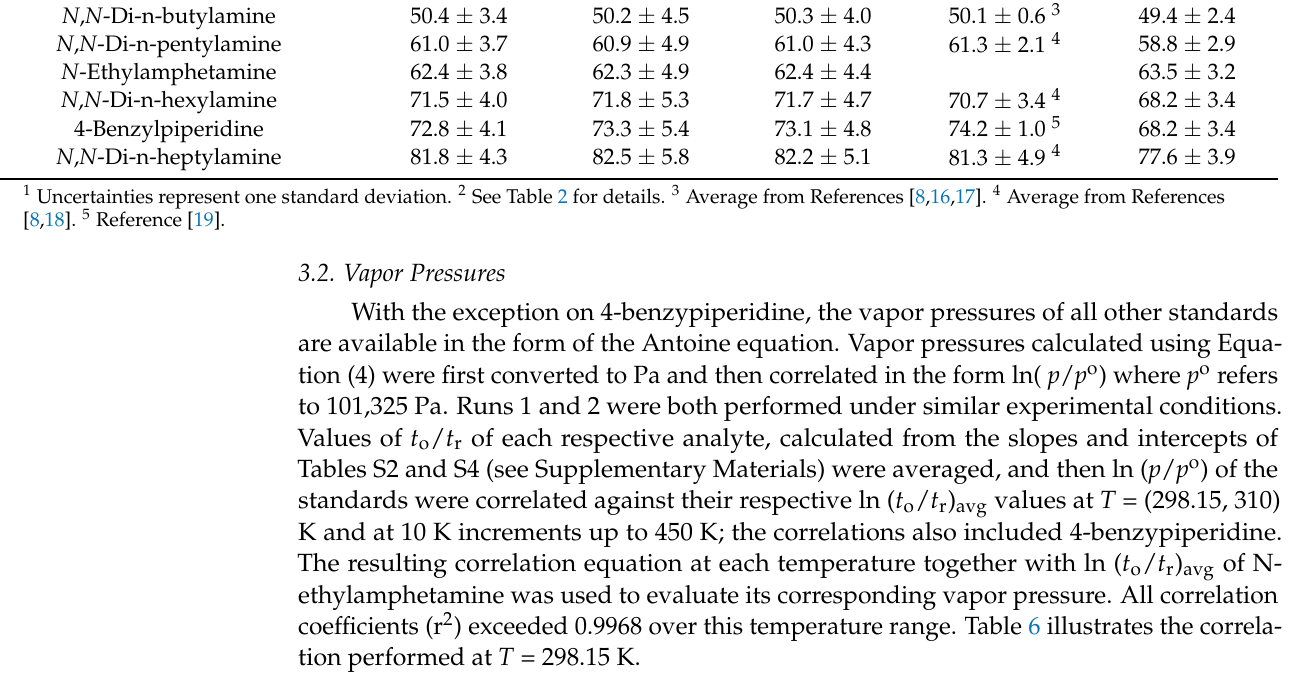
Table 6. Correlations of ln ( p / p o ) vs ln ( t o / t r ) at T = 298.15 K. ln( t o / t r ) ln( p / p o ) ln( p / p o